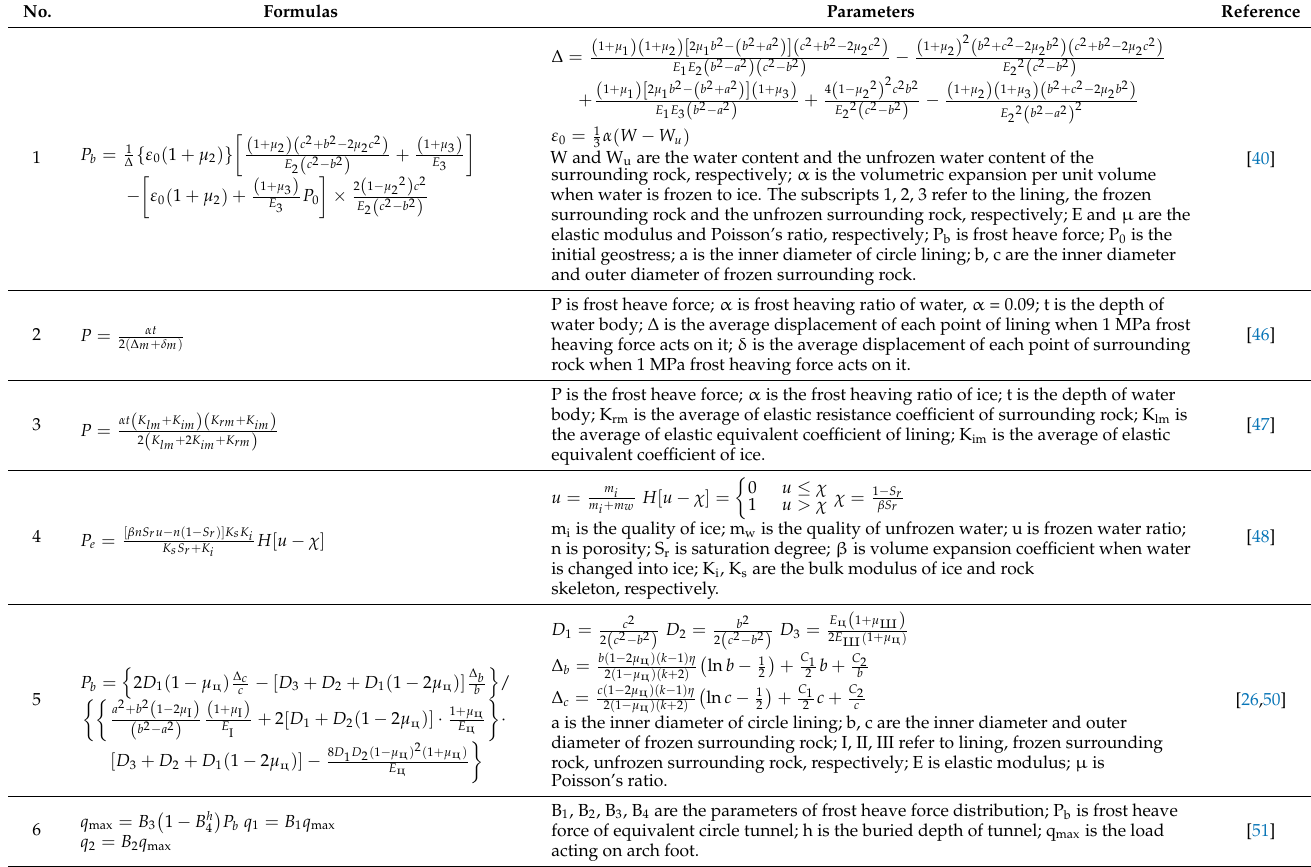
Table 3. Formulas for the frost heaving